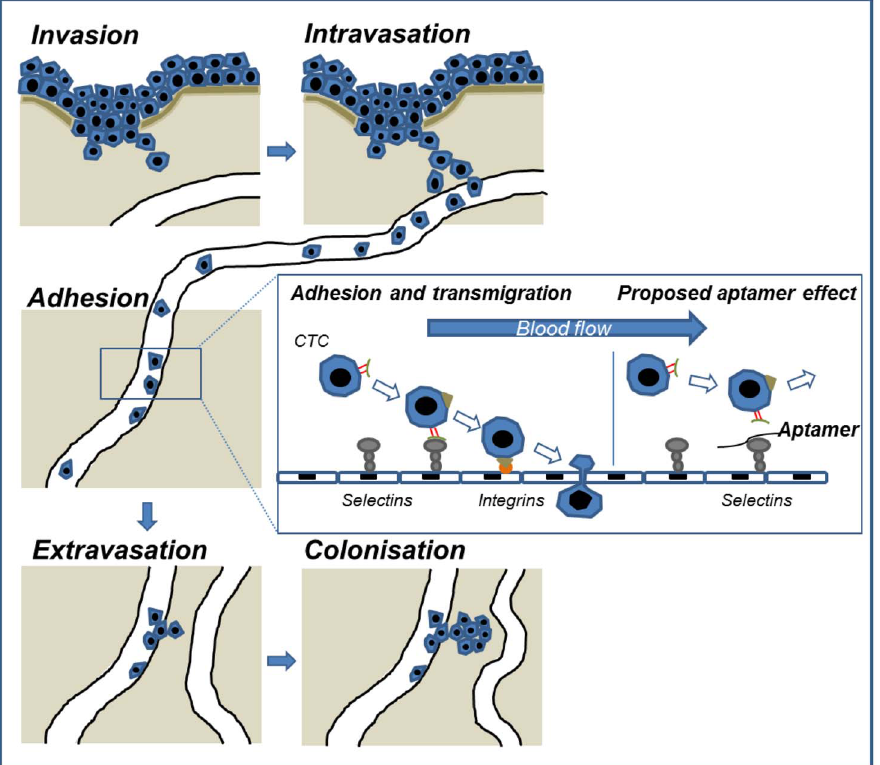
Figure 1. Adhesion of circulating tumor cells towards vascular endothelium is a critical step in metastasis formation. Metastatic spread of cancers occurs via a sequential process that begins with the invasion of primary tumor cells. After crossing the basement membrane and migrating through the adjacent connective tissue, certain tumor cells intravasate into tumor microvessels and circulate with the blood stream to distant organs. At the future metastatic site, these circulating tumor cells (CTC) are slowed down from the blood stream and adhere to vascular endothelium. This step is crucially initiated by interactions between endothelial selectins and certain carbohydrate ligands such as sialylated Lewis structures presented at the tumor cell surface. Adhesion is a prerequisite for extravasation and subsequent colonisation of the metastatic tissue. Selectin-binding aptamers that impair the interaction between selectin ligands and endothelial selectins would be therefore a promising new anti- metastatic